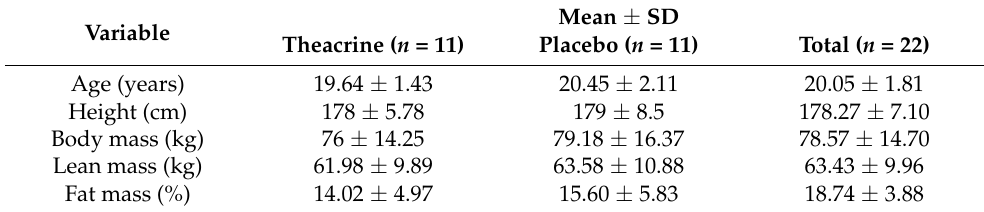
Table 1. General characteristics of the